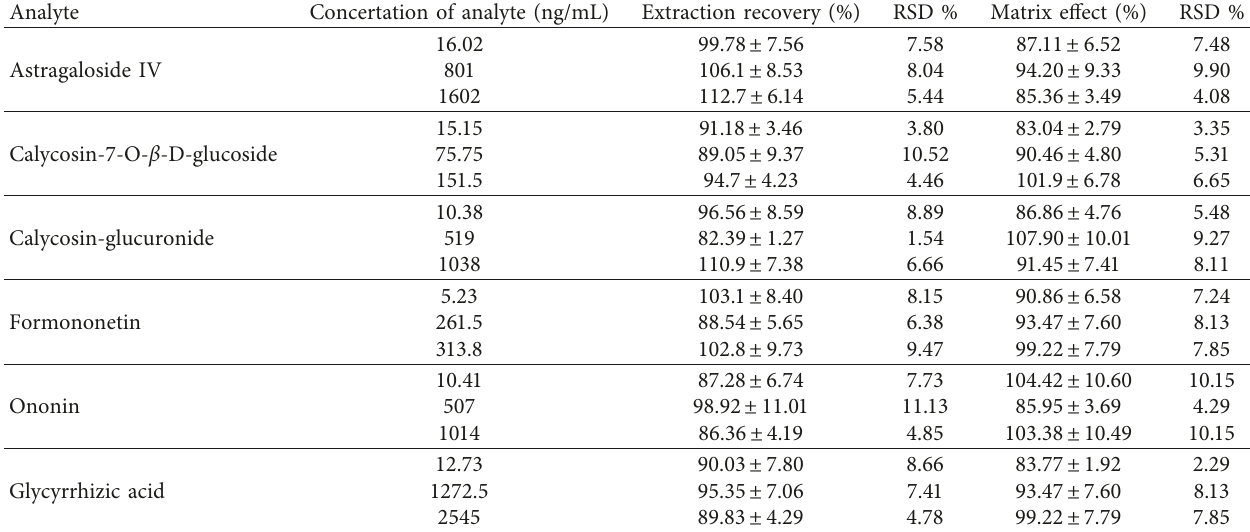
Table 4: Extraction recovery and matrix effect of six analytes in mouse plasma ( x ± SD, n �